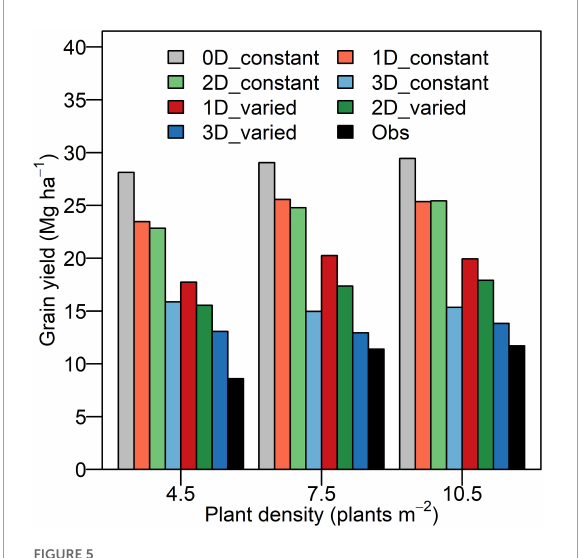
FIGURE5 Simulated grain yield potential and experimental yield at three densities (4.5, 7.5, and 10.5 plants m - 2 ) for XY335. The 0D_constant represents the 0D model with a constant RUE. The 1D_constant, 2D_constant, and 3D_constant represent the 1D, 2D, and 3D models with uniform and constant photosynthetic capacity. The 1D_varied, 2D_varied, and 3D_varied represent the 1D, 2D, and 3D models with heterogeneous and varied photosynthetic capacity. The Obs represents the experimental